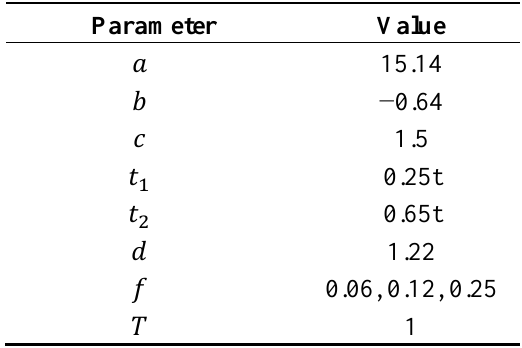
Table 1. Wall Displacement Simulation Parameters.